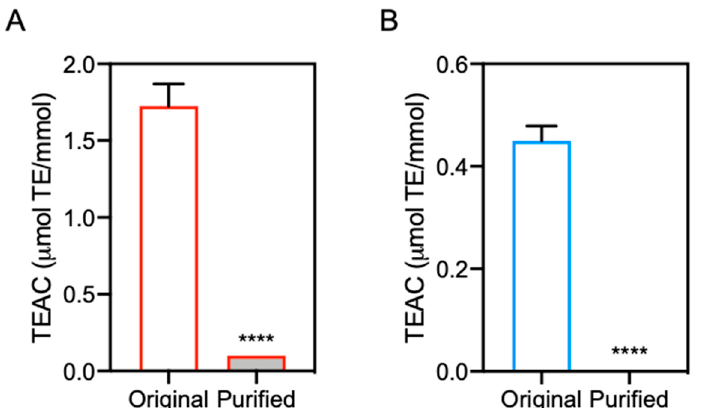
Figure 7. Antioxidant capacity of purified IDPs. The antioxidant capacity of the purified carnosine ( A ) and anserine ( B ) was evaluated by DPPH radical scavenging assay and was compared with that of the original samples, respectively. Data are expressed as TEAC and are represented as means ± SEM ( n = 4). **** p < 0.0001 versus the original sample, compared using unpaired Student’s t test.